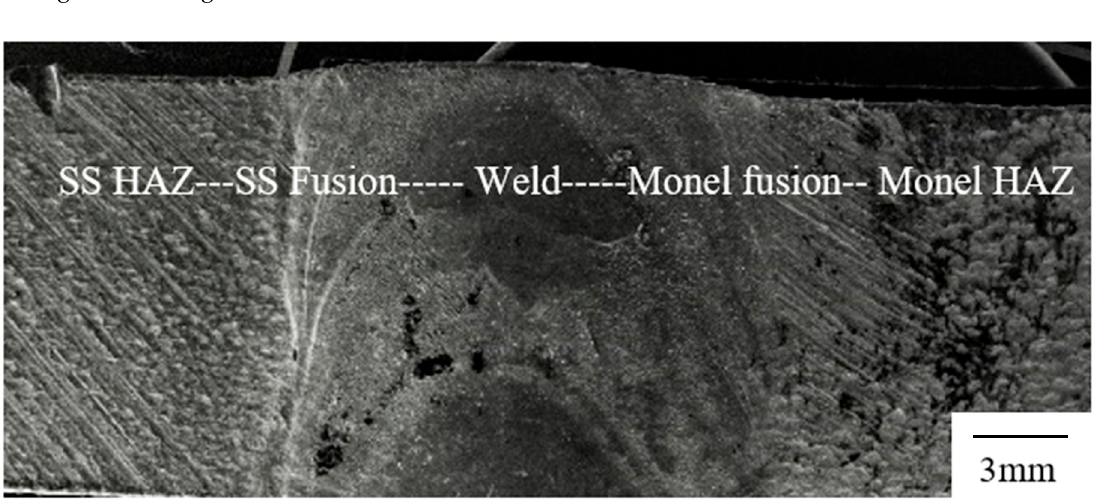
Figure 2. Locations for optical microscopy and Energy dispersive spectroscopy (EDS) for SS316L heat affected zone (HAZ), SS316L fusion line, weld zone, Monel fusion line, and Monel HAZ for heat-treated (HT) specimen (typical).